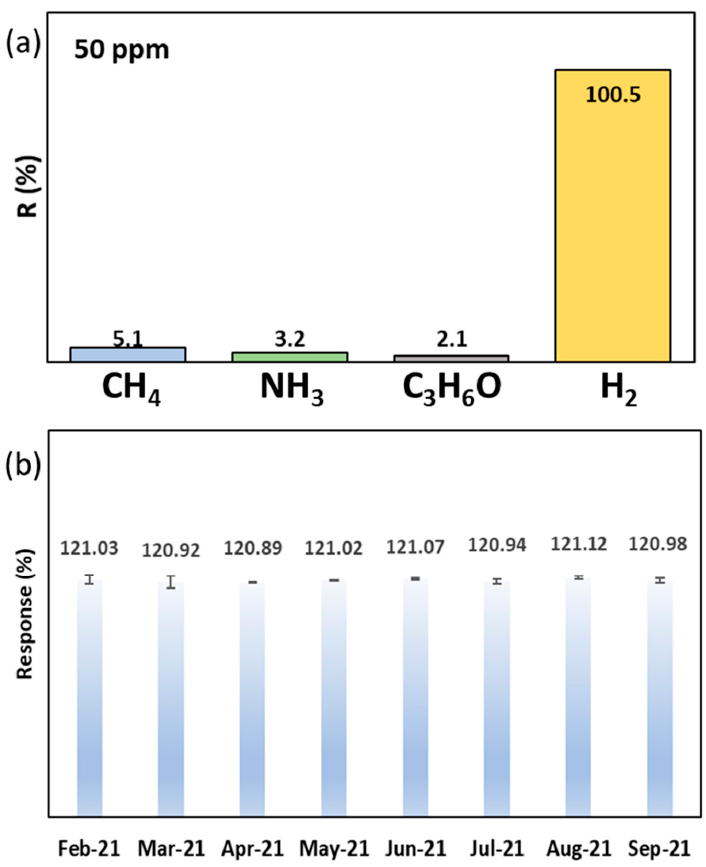
Figure 11. ( a ) Gas selectivity of the Dy 2 O 3 -Pd-PDA/rGO sensor towards 50 ppm of different gases, ( b ) long term stability of the sensor’s response towards 6000 ppm H 2 at 150 °C and 0 %RH over eight months.